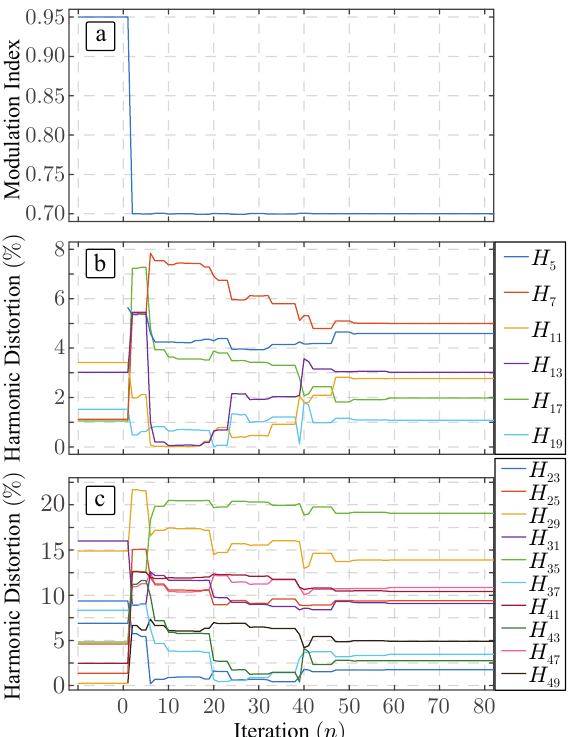
Figure 11. Modulation index and harmonic distortion obtained by the EMA-based SHM method applying a modulation index step from 0.95 to 0.7. ( a ) Fundamental harmonic. ( b ) Harmonic components controlled by the EMA-based SHM. ( c ) The remaining harmonic components up to 49th